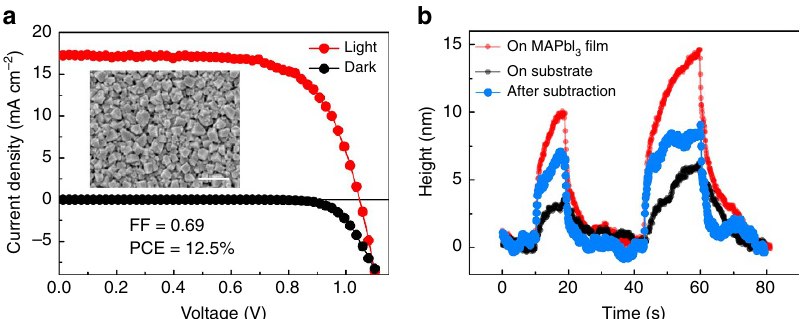
Figure 4 | Photovoltaic and photostrictive properties of MAPbI 3 thin films. ( a ) Typical current density–voltage characteristic of a MAPbI 3 thin-film photovoltaic cell (FTO/TiO 2 /MAPbI 3 /Spiro-OMeTAD/Ag) under simulated AM1.5 100mWcm (cid:3) 2 illumination (red line) and under dark (black line). The power conversion efficiency can reach 12.5%. The inset shows the SEM image of the MAPbI 3 thin film. The scale bar, 1 m m. ( b ) Height change of the MAPbI 3 thin film (4 m m) on FTO-coated glass substrate under illumination. The net response from the film can be obtained by substracting the extrinsic contribution from the substrate. Under 100mWcm (cid:3) 2 white light, about 5nm height change can be observed, corresponding to a photostriction of 1,250p.p.m.